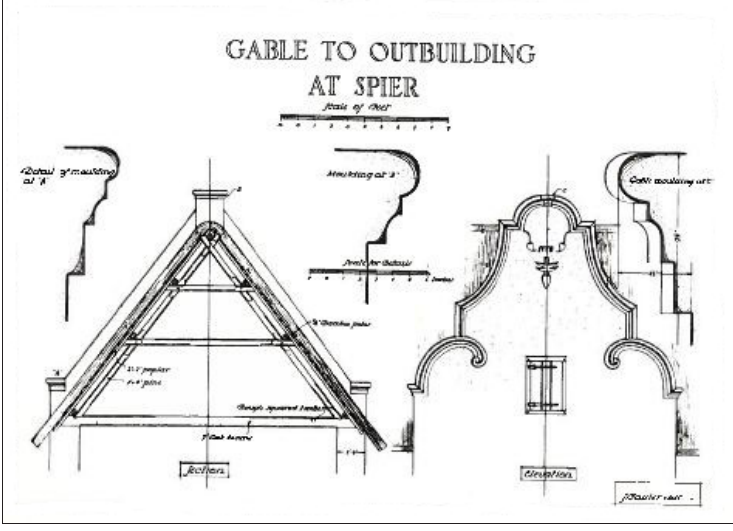
Figure 3: Details of a gable and timber roof structure of Spier